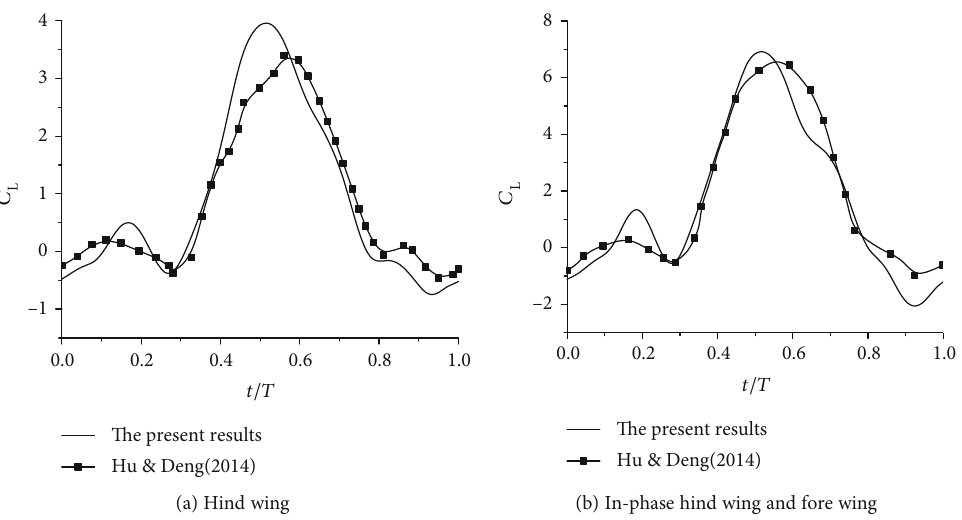
Figure 3: Comparison with Hu and Deng [23] experimental results.